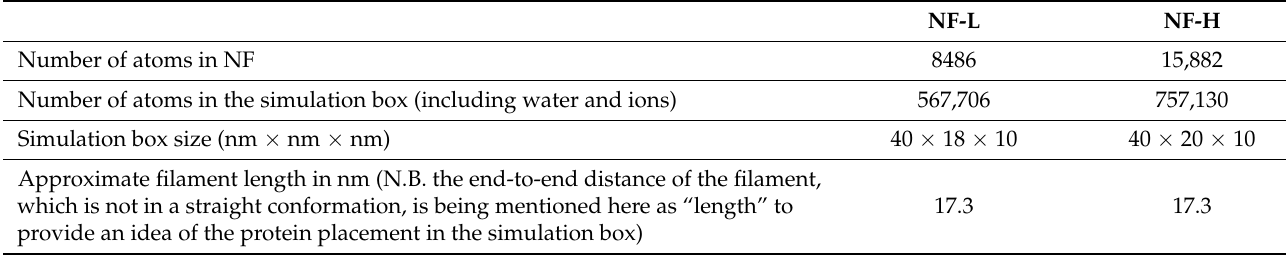
Table A1. Simulation Setup in Terms of Box Size, Number of Atoms, and Filament